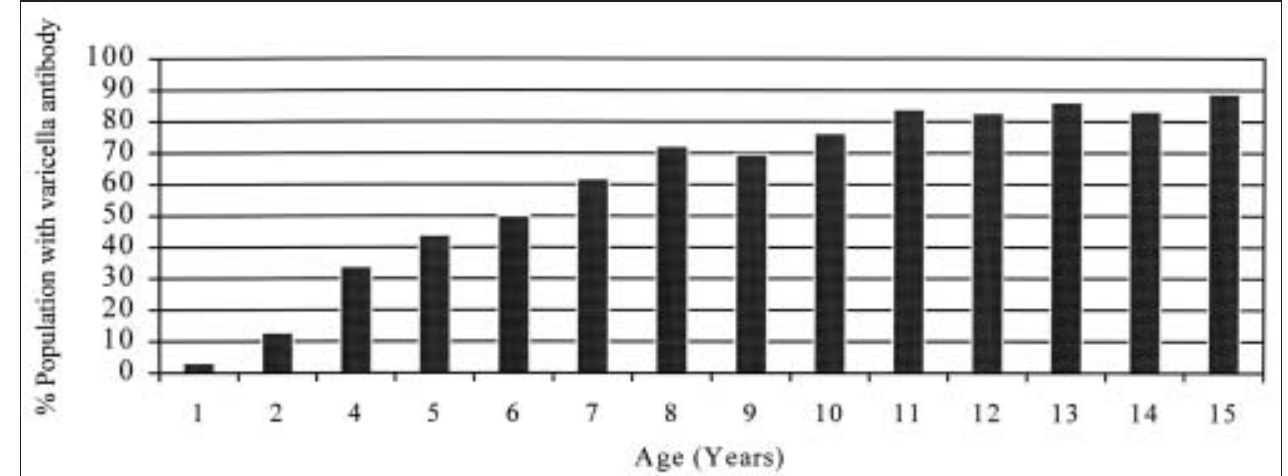
Figure 1) Age-specific prevalence of antibody to varicella zoster virus in a population from Newfoundland. Based on a total of 1721 children and includes a cohort of 586 children who were tested at one, two and four years of age, and a cross-sectional group of 1135 children five to 15 years of